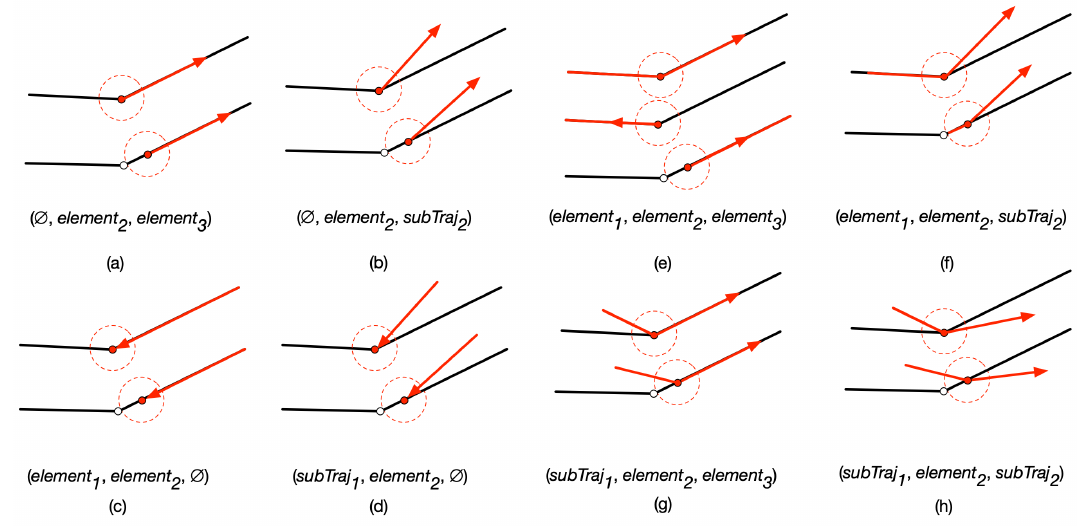
Figure 4. Eight tuples and their trajectory-element intersections. White dots denote nodes, red dots denote keyPoints and arrows denote movement directions. ( a ) Two initial intersections moving inside the network; ( b ) two initial intersections moving outward the network; ( c ) two terminal intersections moving inside the network; ( d ) two terminal intersections moving from outside of the network; ( e ) three basic intersections moving inside the network; ( f ) two basic intersections outward the network; ( g ) two basic intersections moving from outside of the network; ( h ) two basic intersections moving across the